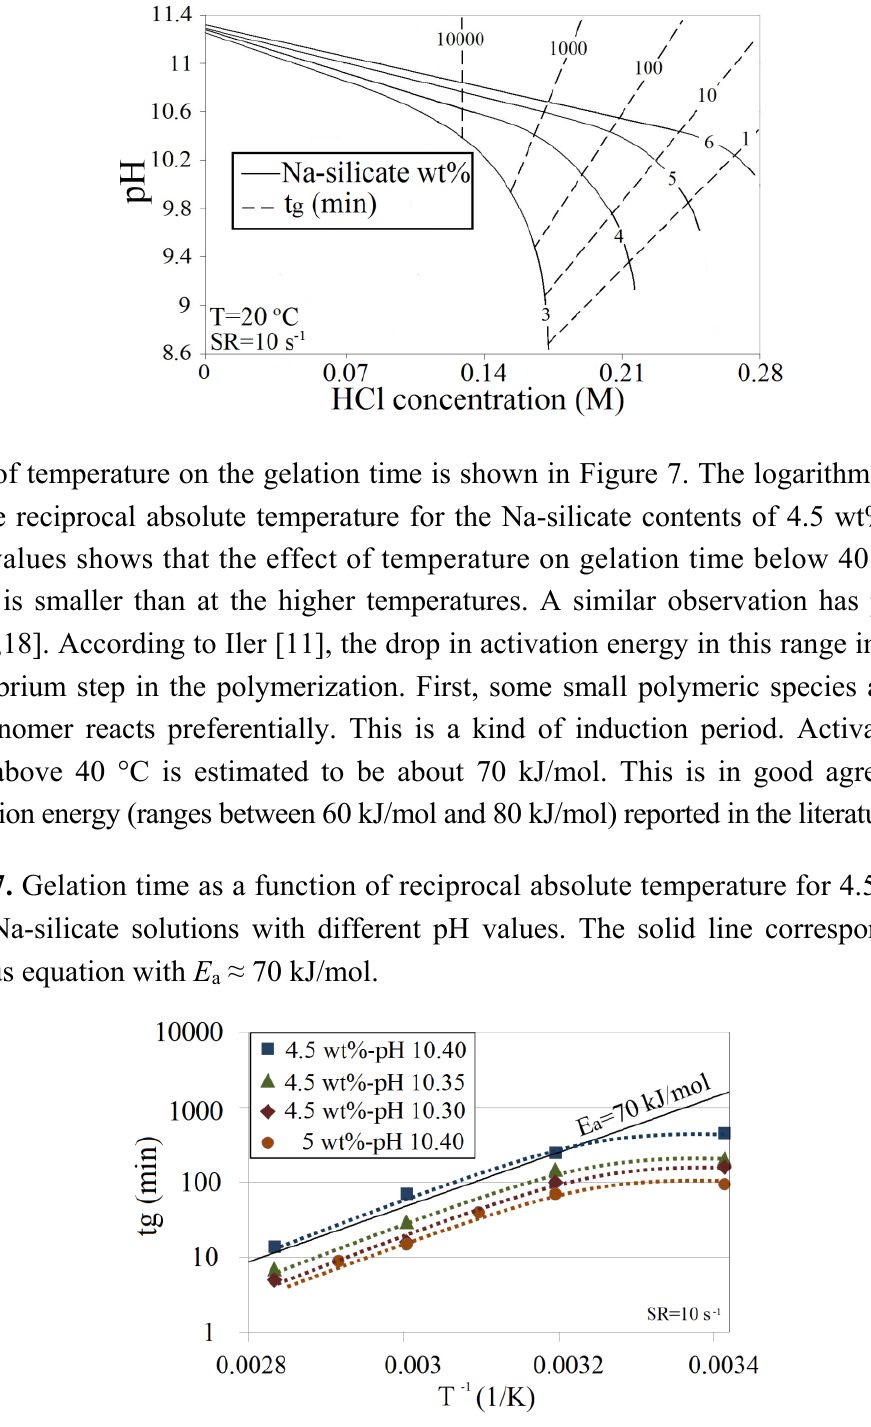
Figure 6. The HCl concentration that must to be added to different silicate contents (3 wt%, 4 wt% and 6 wt% in DW) at 20 °C and a shear rate of 10 s − 1 to obtain the pH value for achieving the target gelation time.